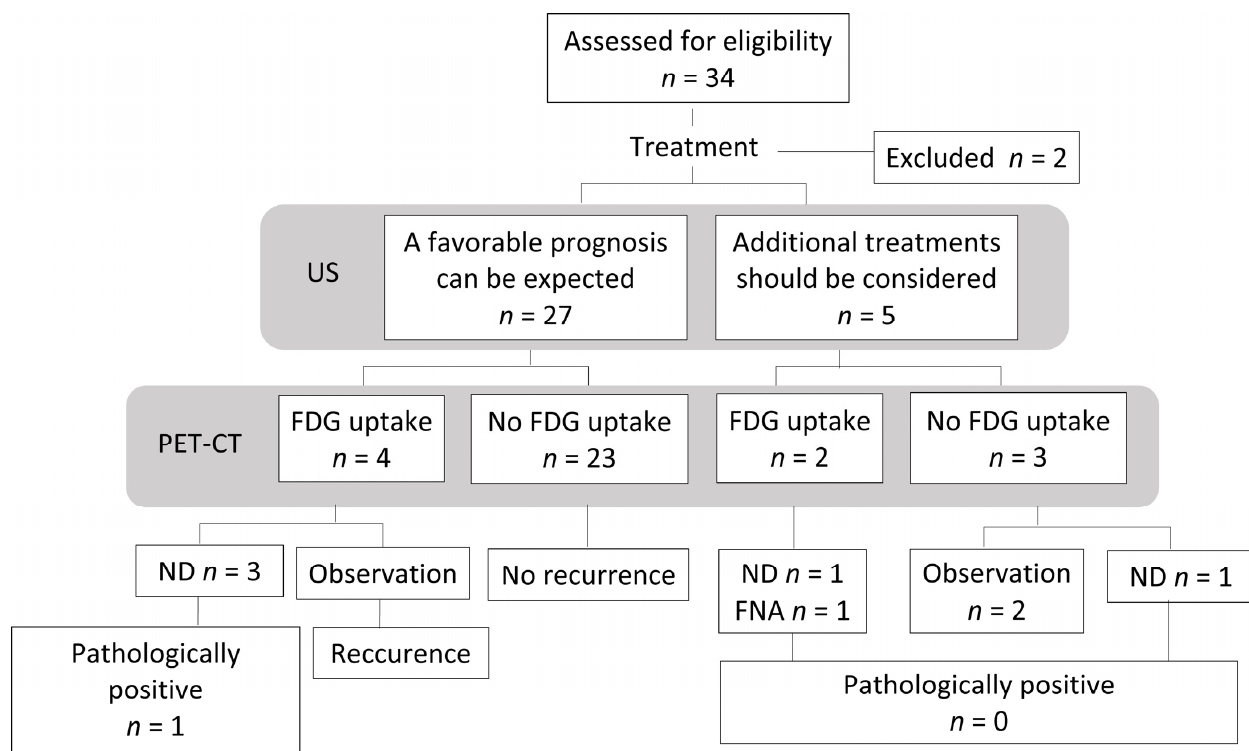
Figure 4. Flowchart of the study population. US, Ultrasonography; PET-CT, 18F-2-fluorodeoxyglucose-positron emission tomography with computed tomography; FDG, fluorodeoxyglucose; ND, neck dissection; FNA, fine needle aspiration cytology.